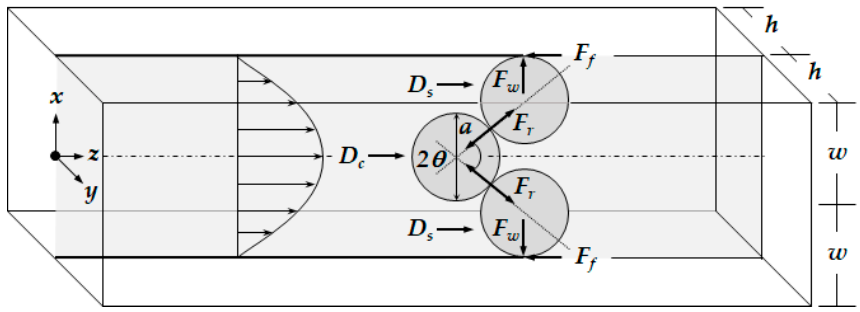
Figure 3. Diagram of the forces acting on the microspheres when the blockage occurs in catheter by arching.